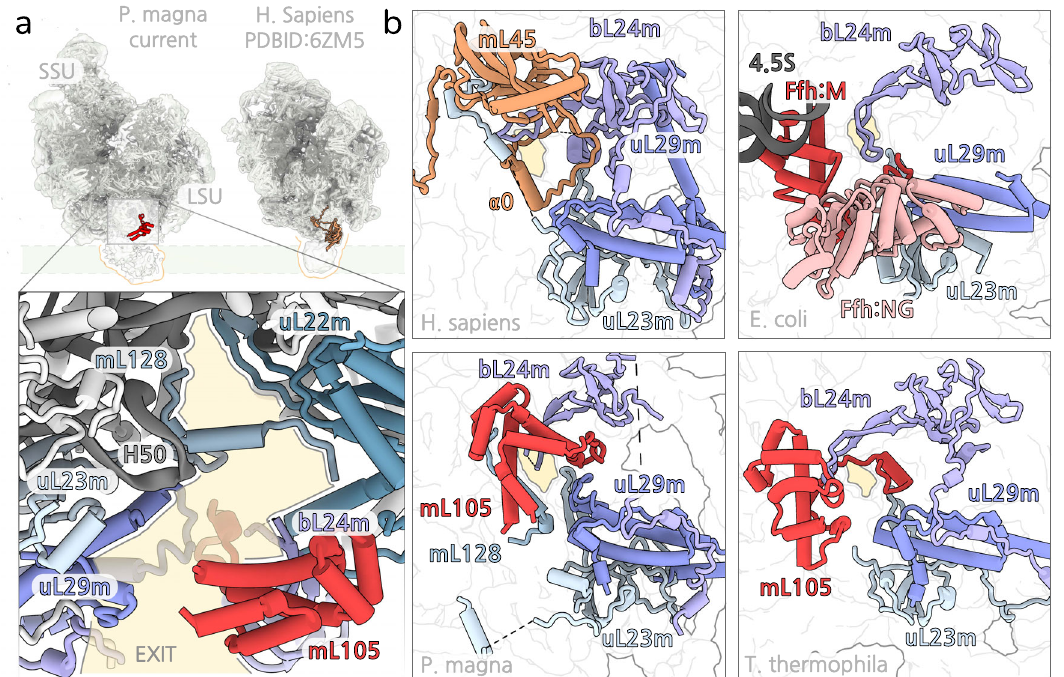
Fig. 6 | Polypeptide exit tunnel and membrane contacts. a Comparison of the density maps between P. magna and H. Sapiens mitoribosomes. The maps were fi ltered to 10Å and aligned on the LSU. mL105 ( P. magna ) shown in red. Zoomed panels illustrate the positionofmL105atthe tunnelexit. mL128anchored constrictsthe path. b Comparisonofthetunnelexitbetween P.magna , H.Sapiens ,